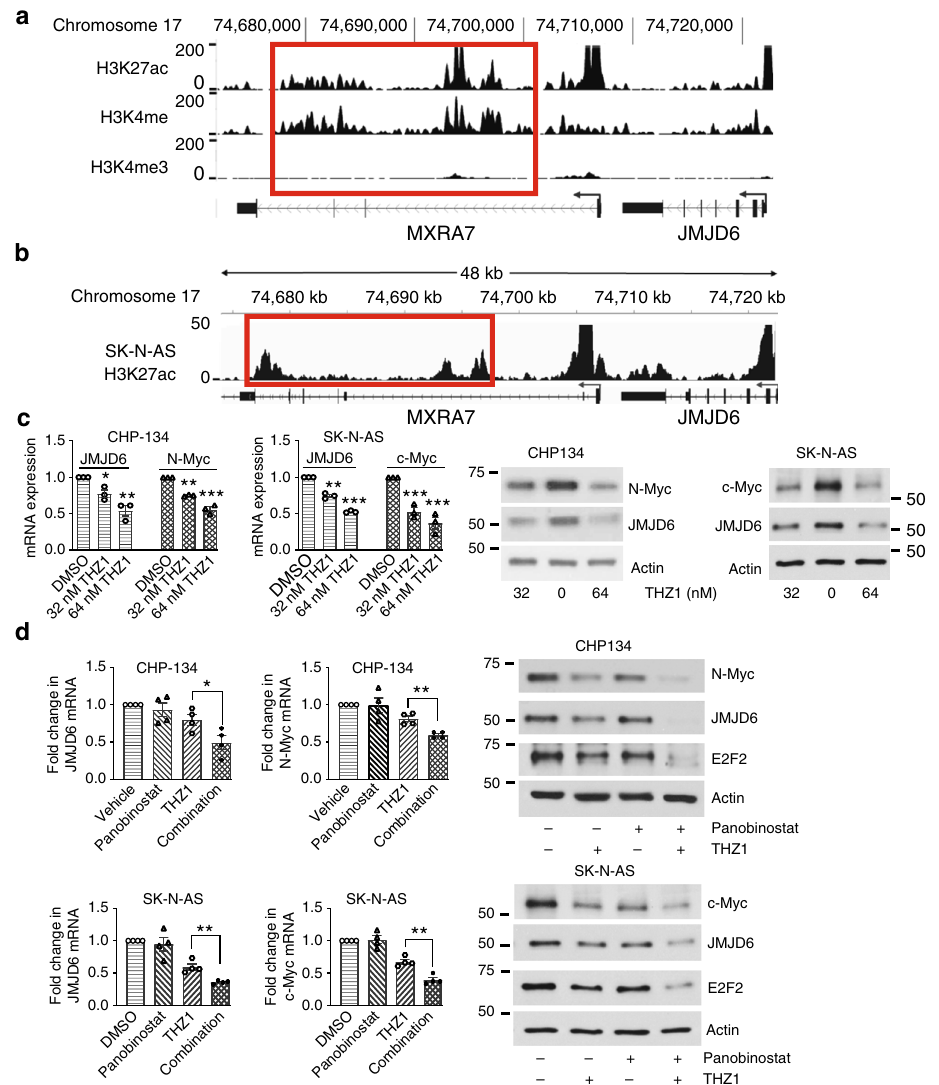
Fig. 6 THZ1 and panobinostat synergistically reduce JMJD6, E2F2, and Myc expression. a ChIP-Seq was performed with control IgG, mono-methyl H3K4 (H3K4me), trimethyl H3K4 (H3K4me3), or acetyl H3K27 (H3K27ac) antibodies in CHP134 cells. H3K4me, H3K4me3, and H3K27ac occupancy at the MXRA7 and JMJD6 gene loci was analyzed. The x- axis indicates genomic position and the y -axis depicts the ChIP-seq signal from each histone mark, in arbitrary units normalized against input control, and super enhancer regions were boxed in red. b ChIP-Seq pro fi ling for H3K27ac occupancy at the MXRA7 and JMJD6 gene loci in SK-N-AS cells was analyzed, using the published Series GSE90683 dataset. c CHP134 and SK-N-AS cells were treated with vehicle control, 32 or 64 nM THZ1. RNA and protein were extracted from the cells 24 and 48 h later, respectively, and subjected to RT-PCR and immunoblot analysis of JMJD6, N-Myc, and c-Myc mRNA and protein expression. Error bars represent normalized standard errors from three independent experiments (* p < 0.05, ** p < 0.01, *** p < 0.001, two-way ANOVA). d CHP134 and SK-N-AS cells were treated with vehicle control, 32 nM THZ1, 10 nM panobinostat, or combination of THZ1 and panobinostat for 48 h, followed by RT-PCR and immunoblot analyses of JMJD6, N-Myc, and c-Myc mRNA and protein expression. Error bars represent normalized standard errors from four independent experiments (* p < 0.05, ** p < 0.01, two-tailed unpaired Student ’ s t test). Source data are provided as a Source Data fi